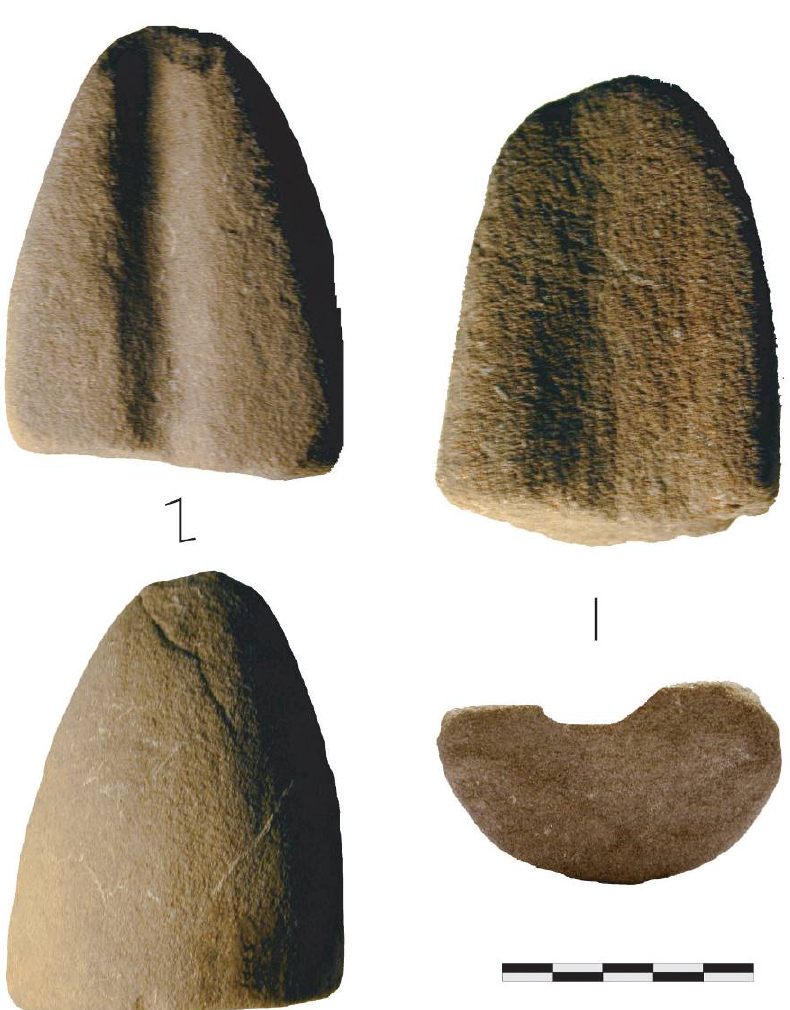
Figure. 2. Comparison of two longitudinally grooved abraders in Thanetien sandstone from Trosly-Breuil «les Obeaux» (Oise) and from the Linear Pottery site of Etigny “le Brassot-est” (Yonne) (after Allard et al. 2006).